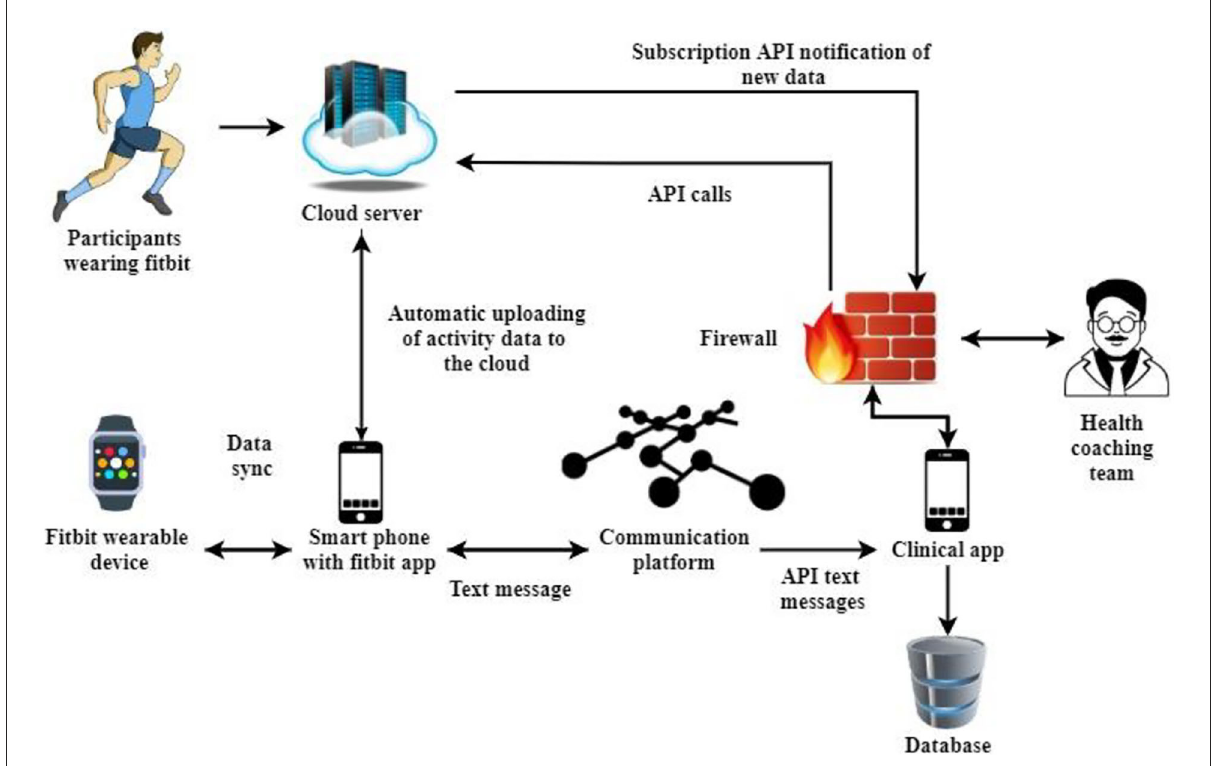
FIGURE4 Cloud interface of the proposed intelligent mobile health monitoring system (Im-HMS).